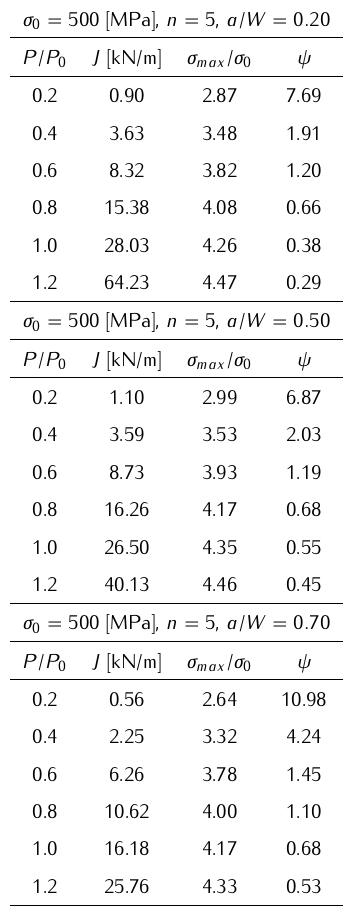
Table B2. Numerical results for CC(T) specimens characterized by yield stress σ MPa and work hardening 0 = 500